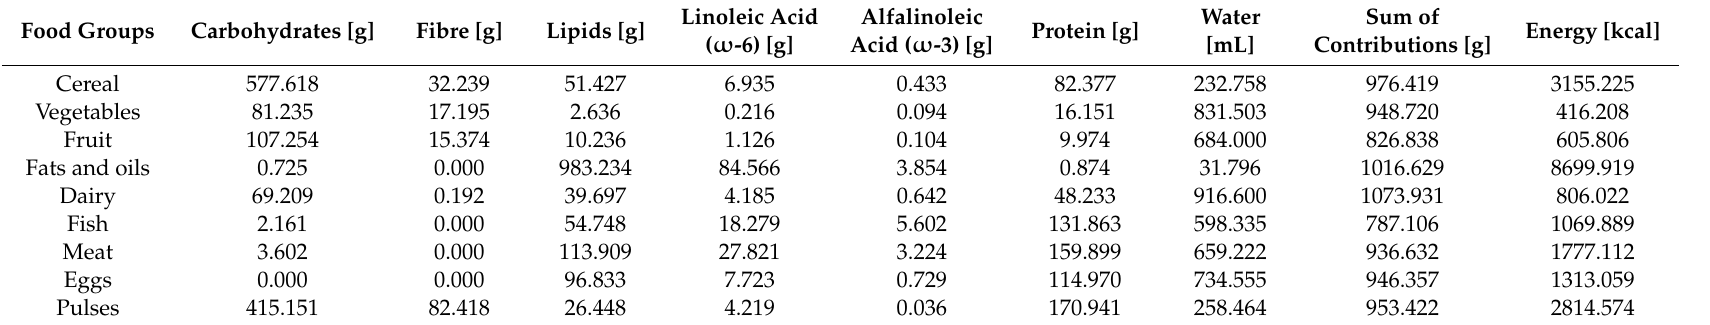
Table 2. Macro-nutritional contribution (without correction).